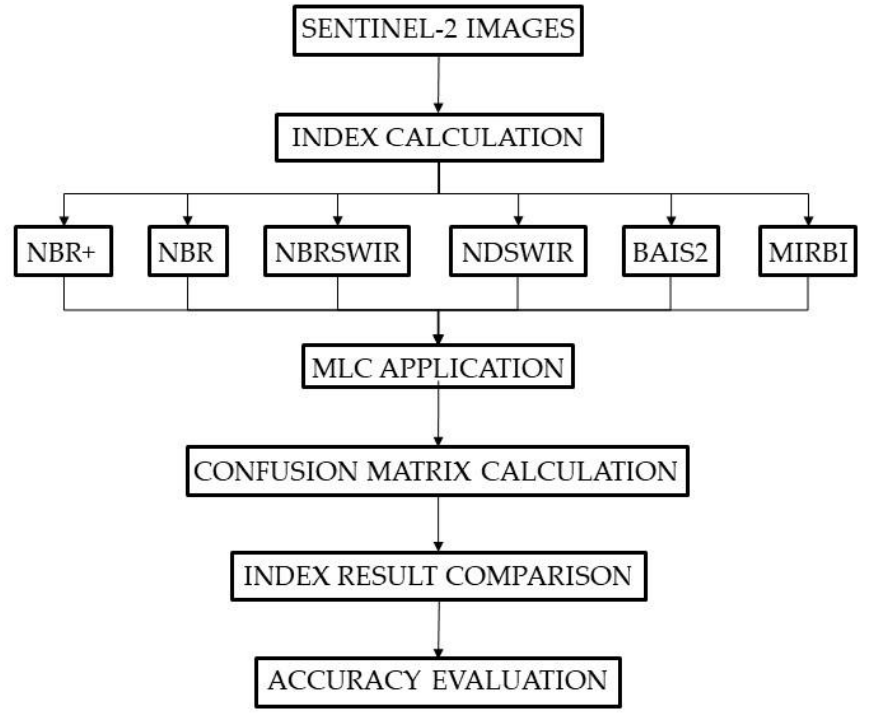
Figure 3. The workflow of the whole methodological approach for testing the performance of the proposed index in comparison with other five indices.